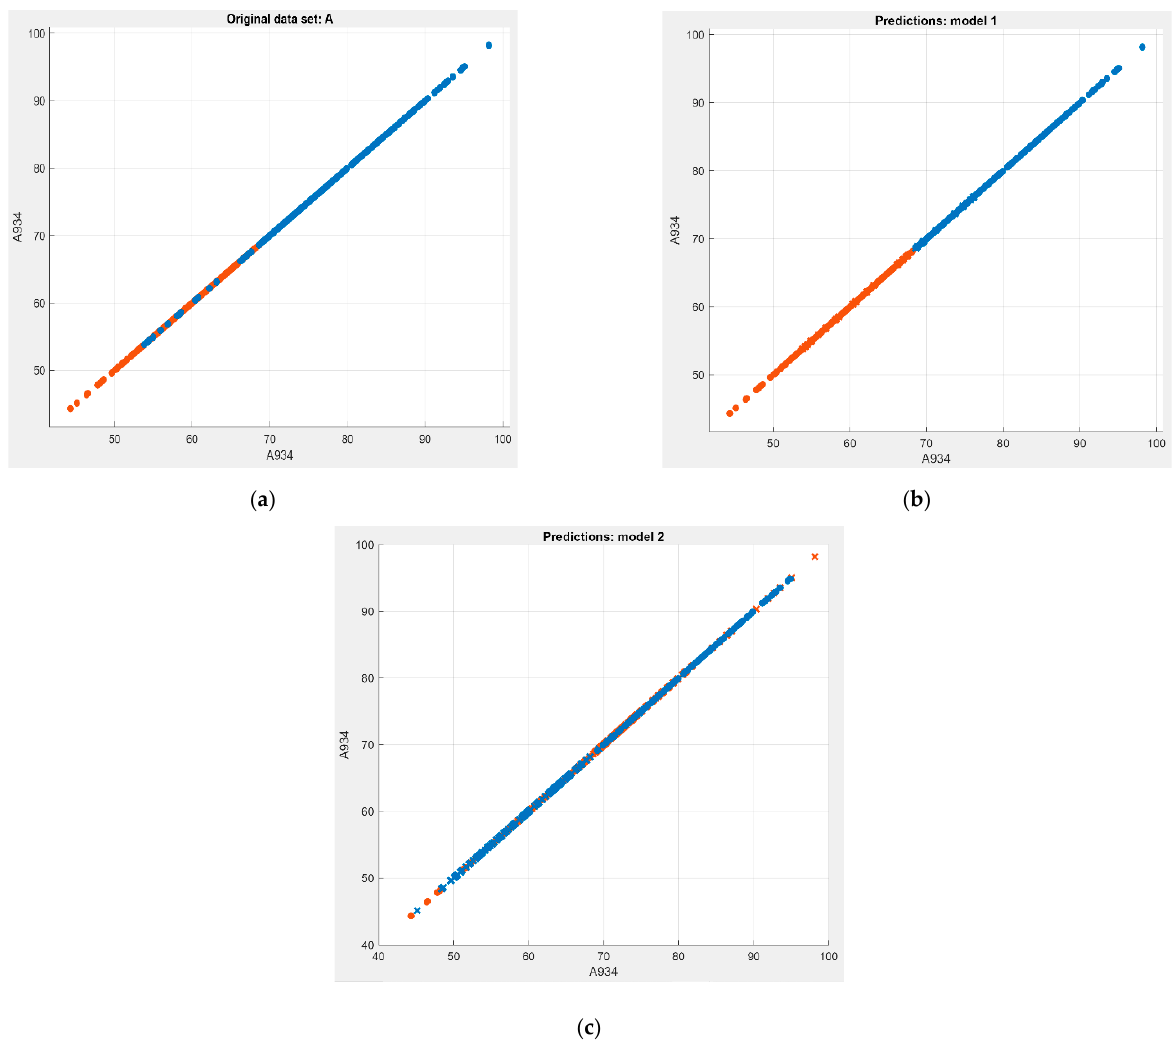
Figure 3. Scatter plot of SVM classification models. ( a ) Original dataset before classified using ( b ) linear SVM and ( c ) cubic SVM.